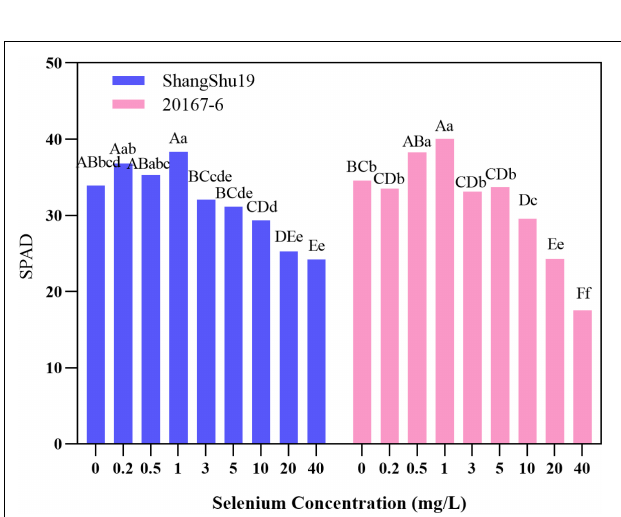
FIGURE 7 | Effects of different selenium concentrations on the maximum photochemical efficiency (Fv/Fm) of PSII after dark treatment of sweet potato. Different lowercase letters in the same category indicated that there were significant differences between Se treatments (Sig < 0.05); Different capital letters in the same category indicated that there were significant differences between Se treatments (Sig < 0.01).